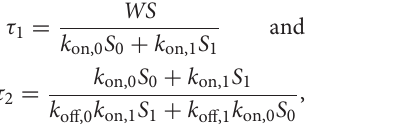
FIGURE 7 | Modified sine-law ˜ 1 steady as a function of the inclination angle θ . Comparison between the model prediction for P (Equation 19 with R 25 and A 1.3, red line) and experiments on wheat coleoptiles (symbols, Chauvet et al., 2016). Geometrical parameters used in the model = = for the statocyte are H stato 4 d , W 10 d , H 25 d where d stands for the diameter of a statolith. Error bars are the mean value of the data by binning the [0,180] = = = interval into 20